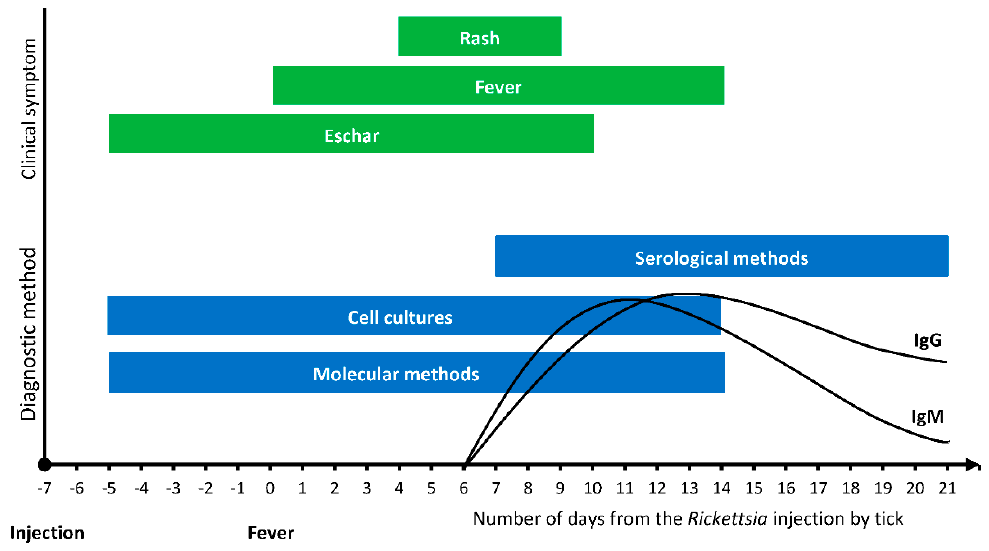
Figure 3. The usefulness of diagnostic methods in the course of tick-borne rickettsioses [124].